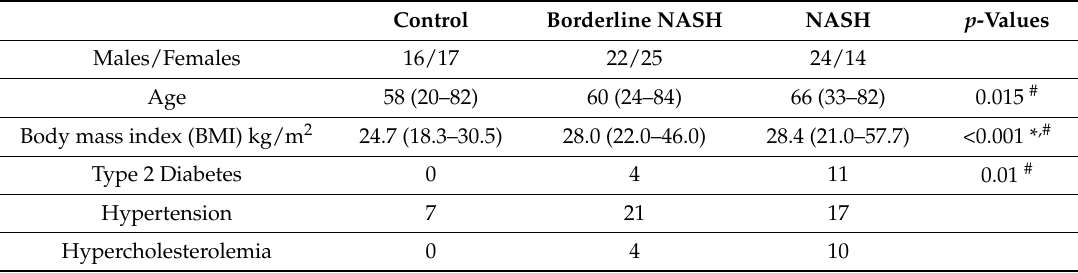
Table 1. Characteristics of the cohort enrolled in the present study. Data are given as median values and range of the values. Uppercase numbers are shown where data were not available for all of the patients. Significant differences between controls and patients with borderline non-alcoholic steatohepatitis (NASH) are identified by *, between controls and patients with NASH with # and between patients with borderline NASH and NASH with &